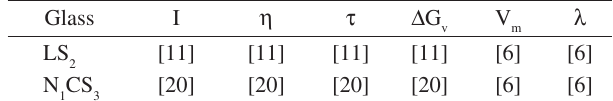
Table 1. Sources of experimental data used to compute σ